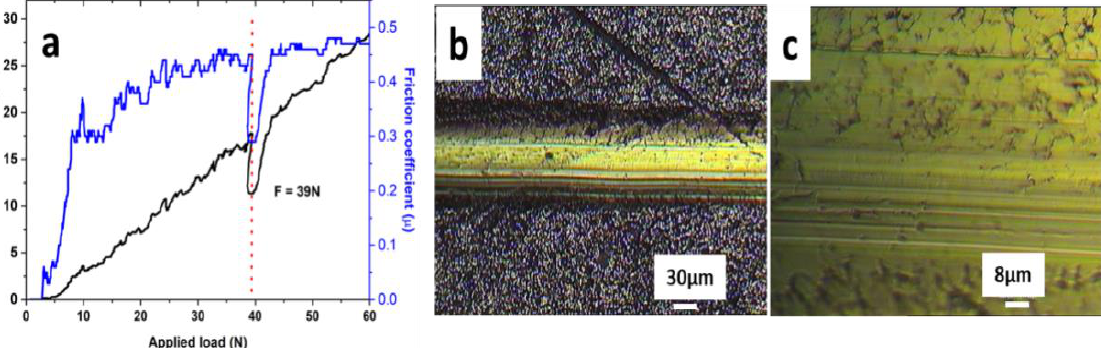
Figure 6. ( a ) The curve of friction and the corresponding friction coefficient versus the applied load during the scratching process, ( b ) Optical images of scratching tracks of the Ni – Co – P/Si 3 N 4 composite coating, ( c ) Optical image of the scratching tracks at a higher magnification than ( b ).